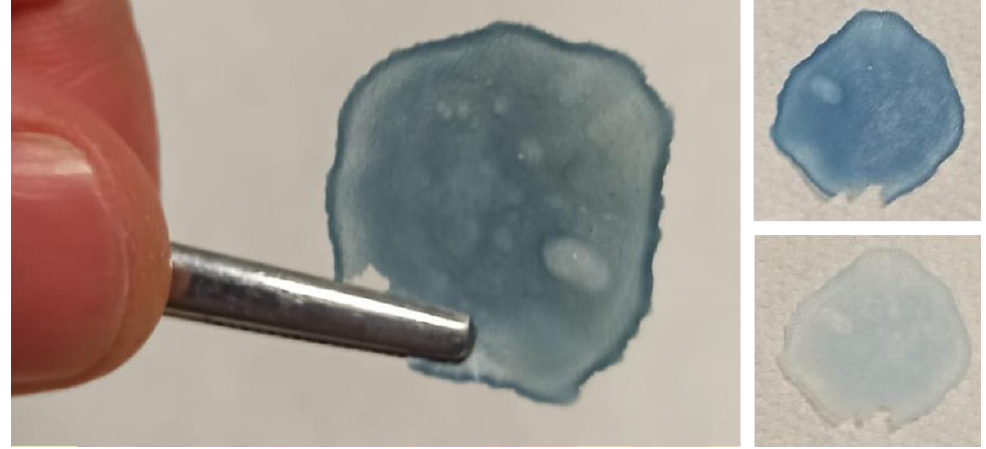
Figure 5. Pictures of photochromic freestanding membrane both in bleached and colored states.